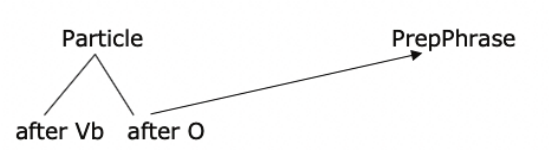
Figure 3: eliminating variants (English